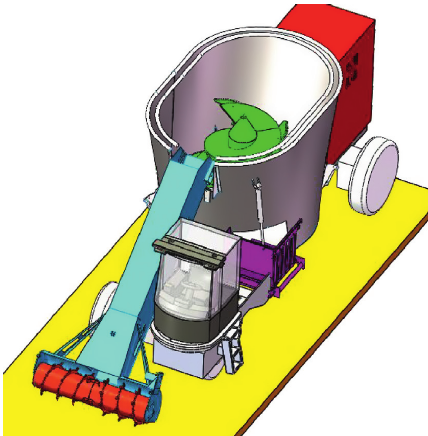
Figure 2: 3D rendering of the self-propelled TMR